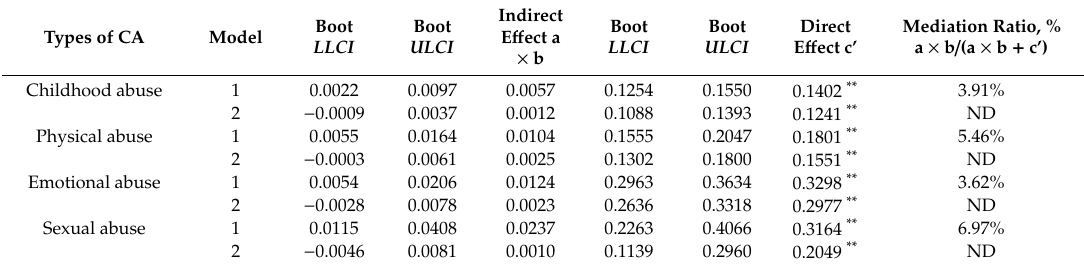
Table 3. Mediation e ff ects of social support between CA and NSSI in the full